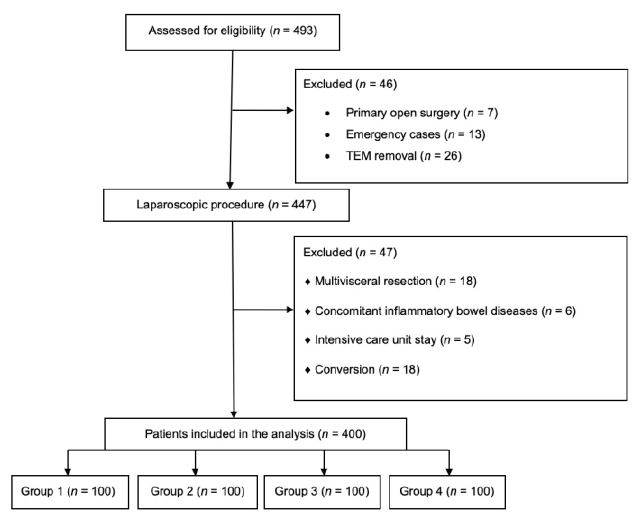
Figure 1. Patients flow through the study. TEM: transanal endoscopic microsurgery.